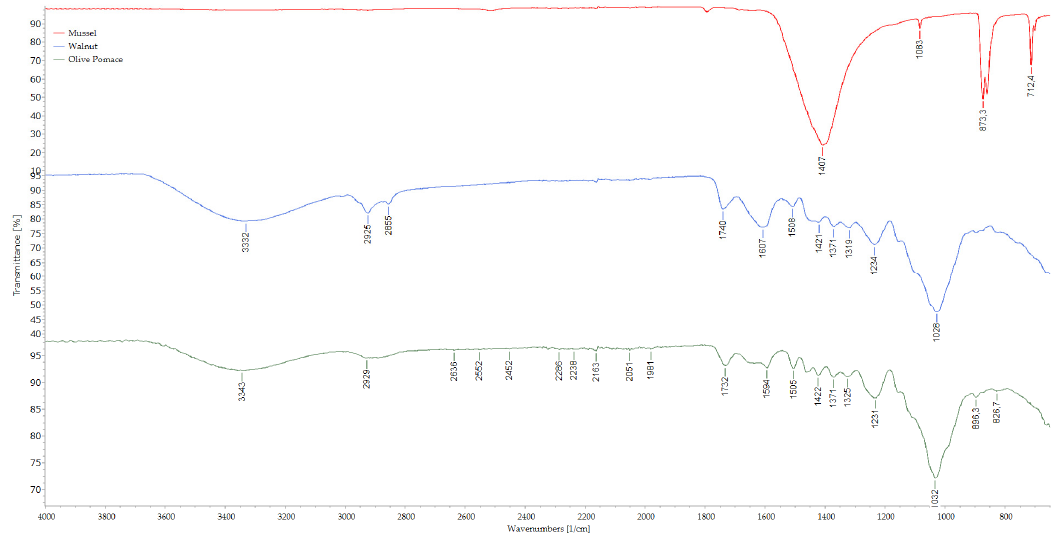
Figure 1. Ground 38 µm ( a ) olive pomace, ( b ) walnut, and ( c ) mussel powders and ground 45 µm ( d ) olive pomace, ( e ) walnut, and ( f ) mussel powders.